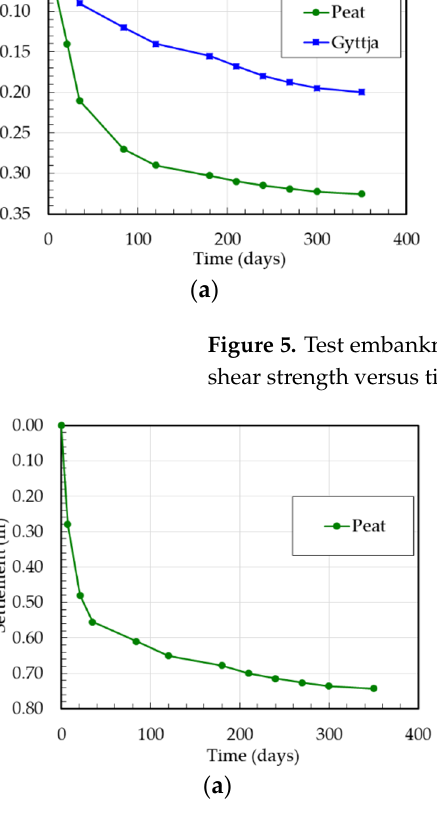
Figure 6. Test embankment No. 4 at the Bia ł o ś liwie site: ( a ) settlement versus time, ( b ) undrained shear strength versus time.